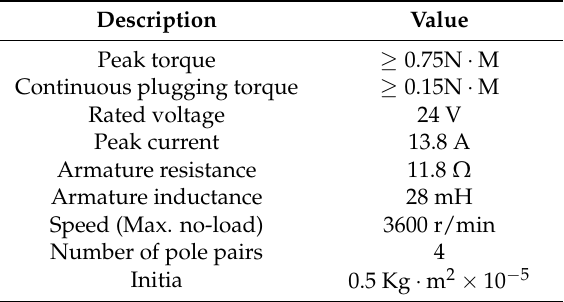
Table 1. Parameters of